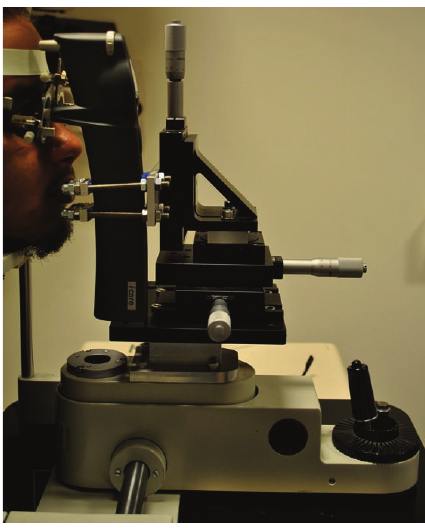
Figure 1: Side view of the subject with the headrest and slit lamp base to which the bespoke rig was attached and the iCare tonometer fixed in place. The micrometer scale gauges used to modify the tonometer’s position can be